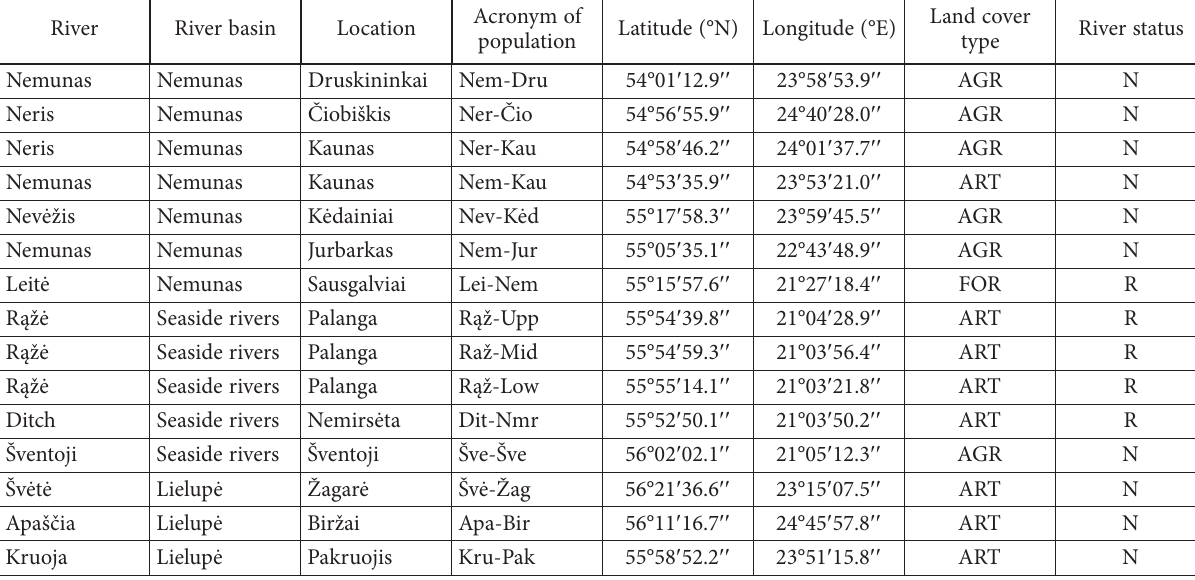
Table 1. Titles, geographic location and environment characteristics of Lithuanian populations of purple loosestrife ( Lythrum salicaria )